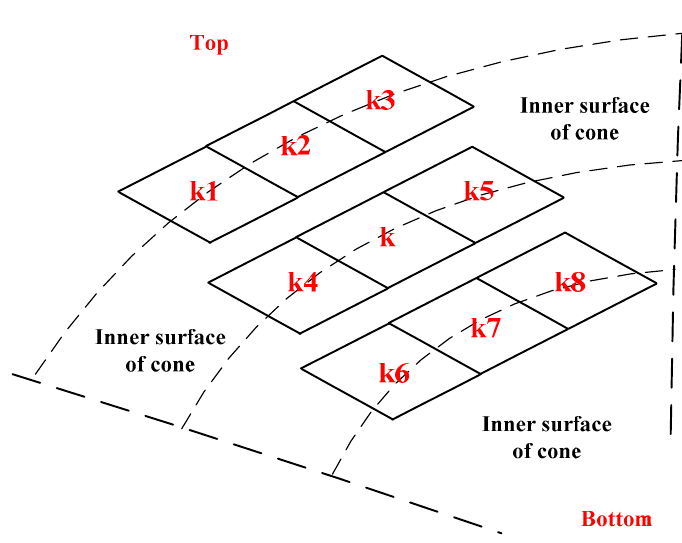
Figure 3. Spatial distribution of a central digital elevation model (DEM) cell and its eight adjacent cells in the drainage basin cone.